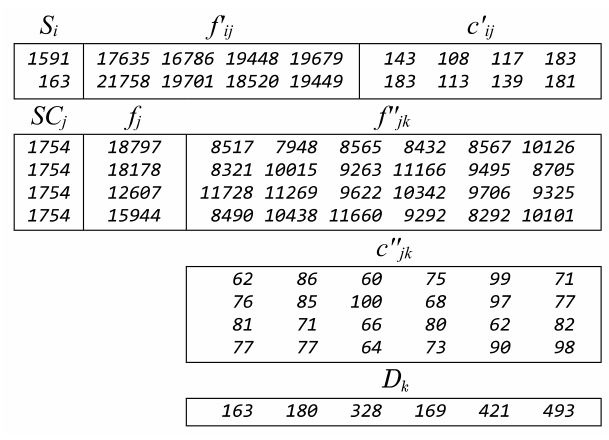
Figure 2. The characteristics of the example described by Hong et al.